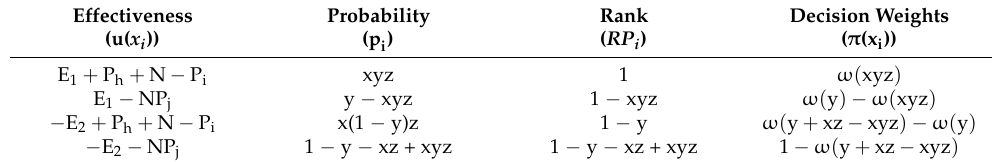
Table 4. Ranking of the expected benefits of the